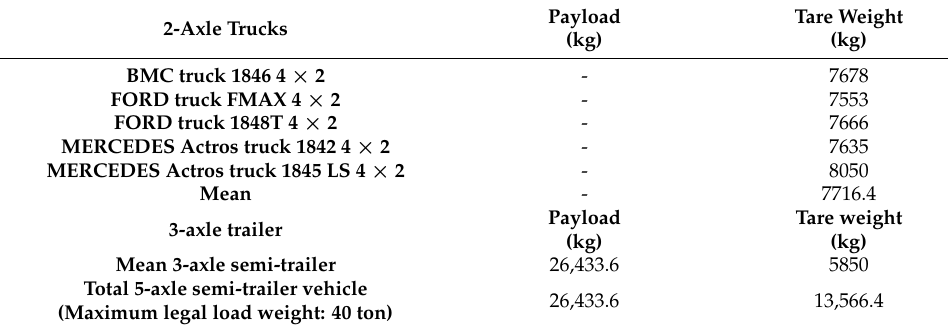
Table 16. The 5-axle semi-trailer vehicle mean payload and tare weight